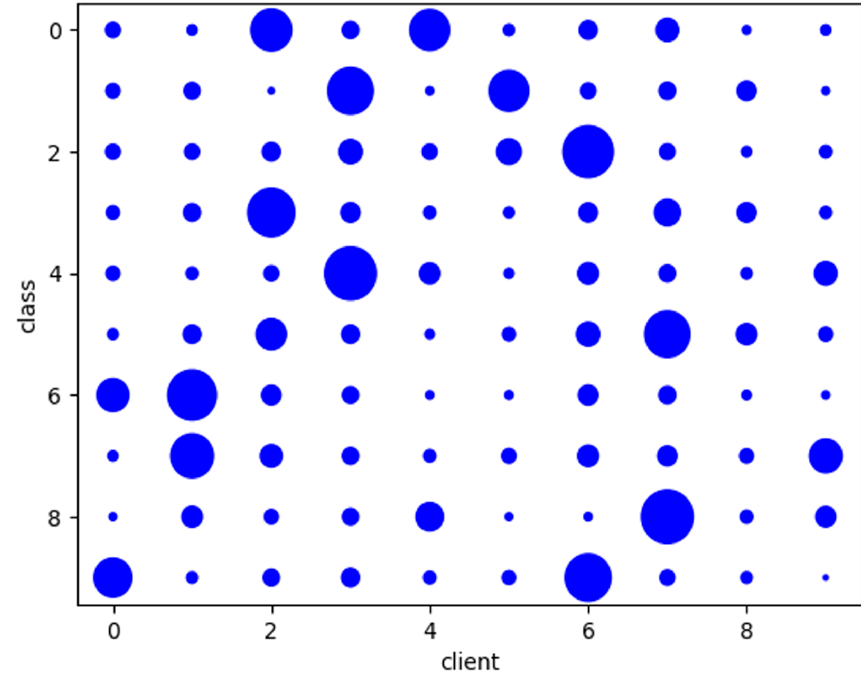
Figure 8. The statistical distribution of the top-1 SoftMax outputs’ entropy.